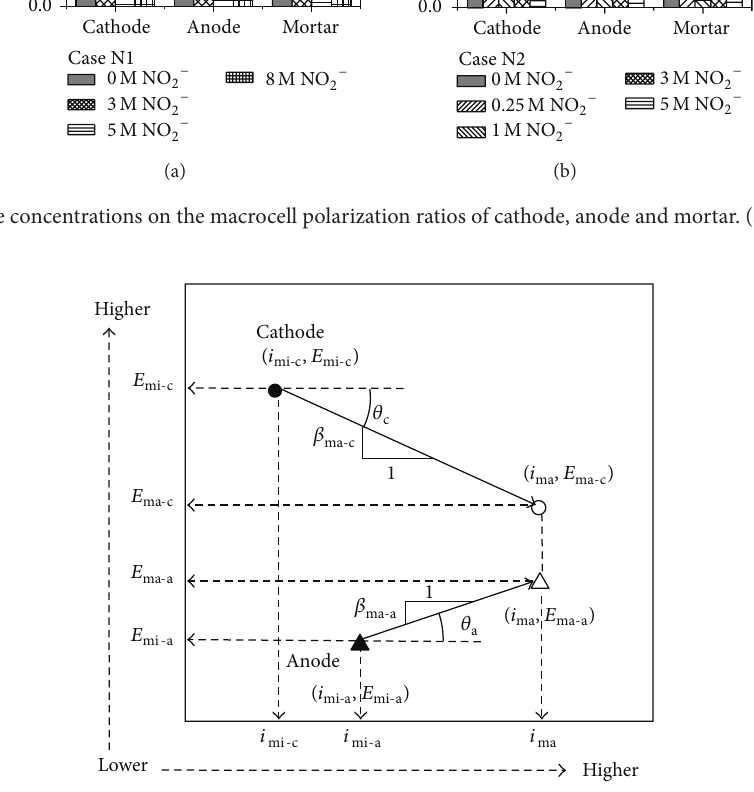
Figure 9: Definition of macrocell polarization slopes and angles of cathode and anode